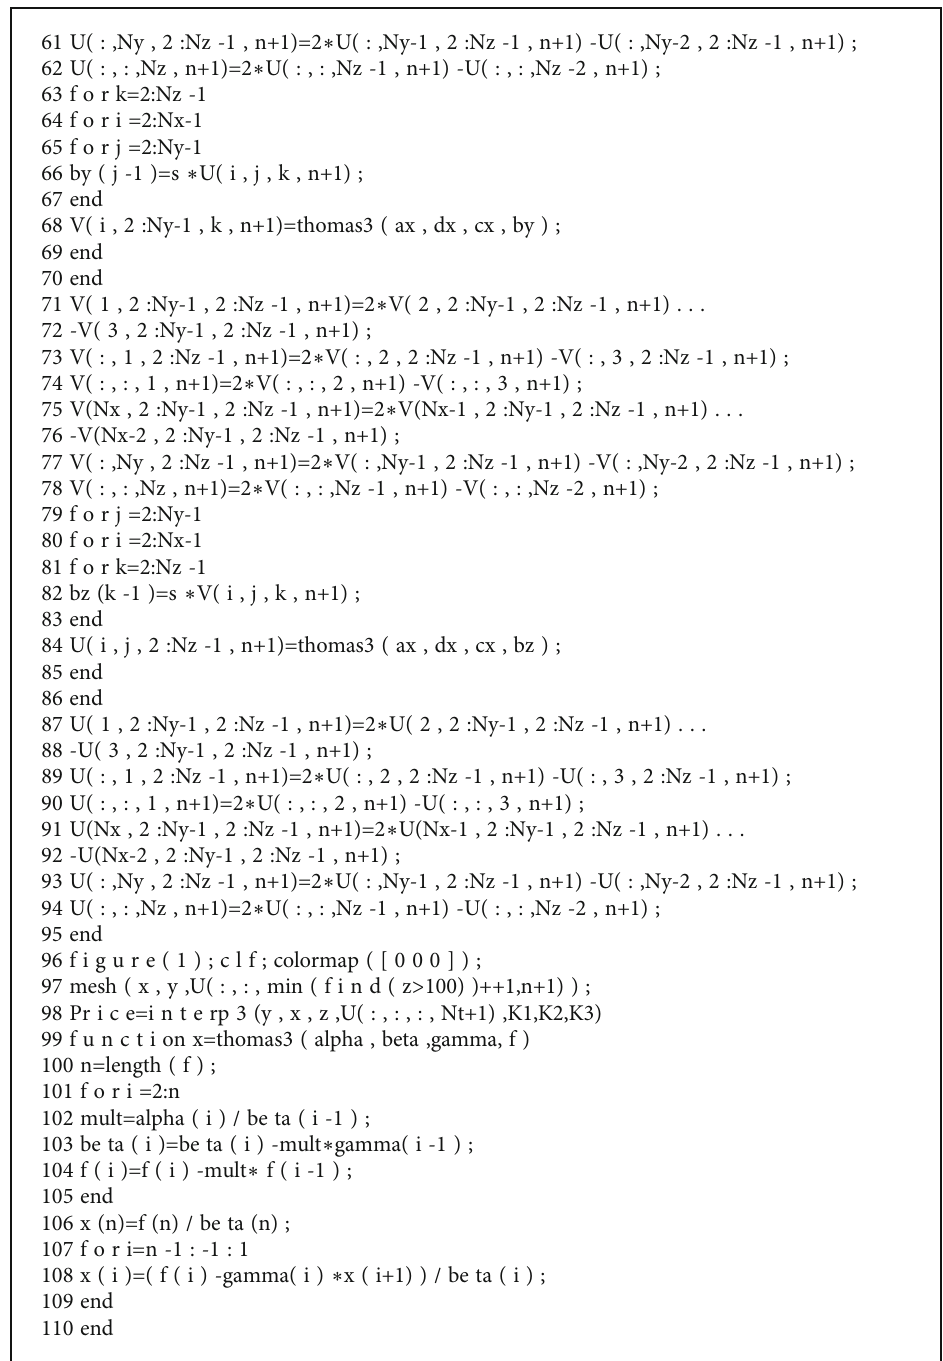
parameters are the same as in the tests previously. In Figure 9, the solid and dashed curves are the CPU time and prices, respectively, with respect to uniform mesh with mesh size h = 2, 3, ⋯ , 8 . Here, the uniform mesh